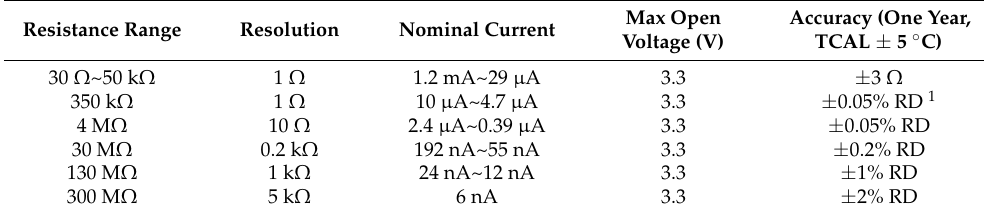
Table 1. Specifications of the measurement ranges and errors.